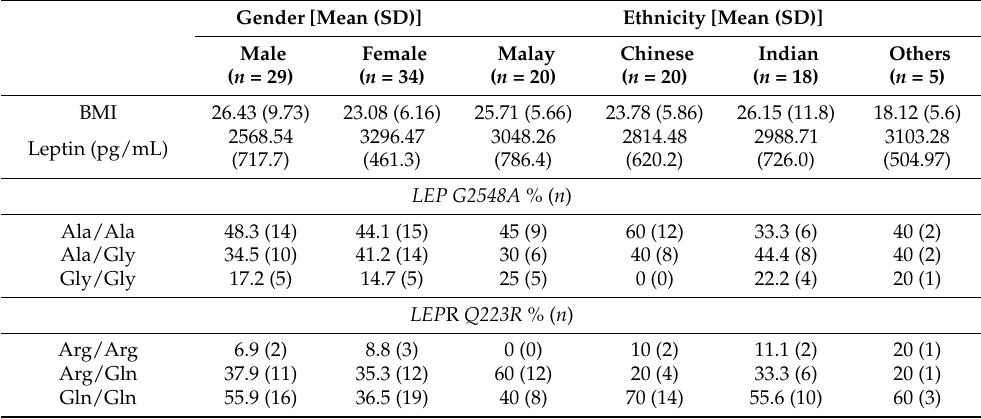
Table 2. Descriptives Statistics of leptin, LEP, and LEPR observed in both the gender and ethnic population. Gender [Mean (SD)]